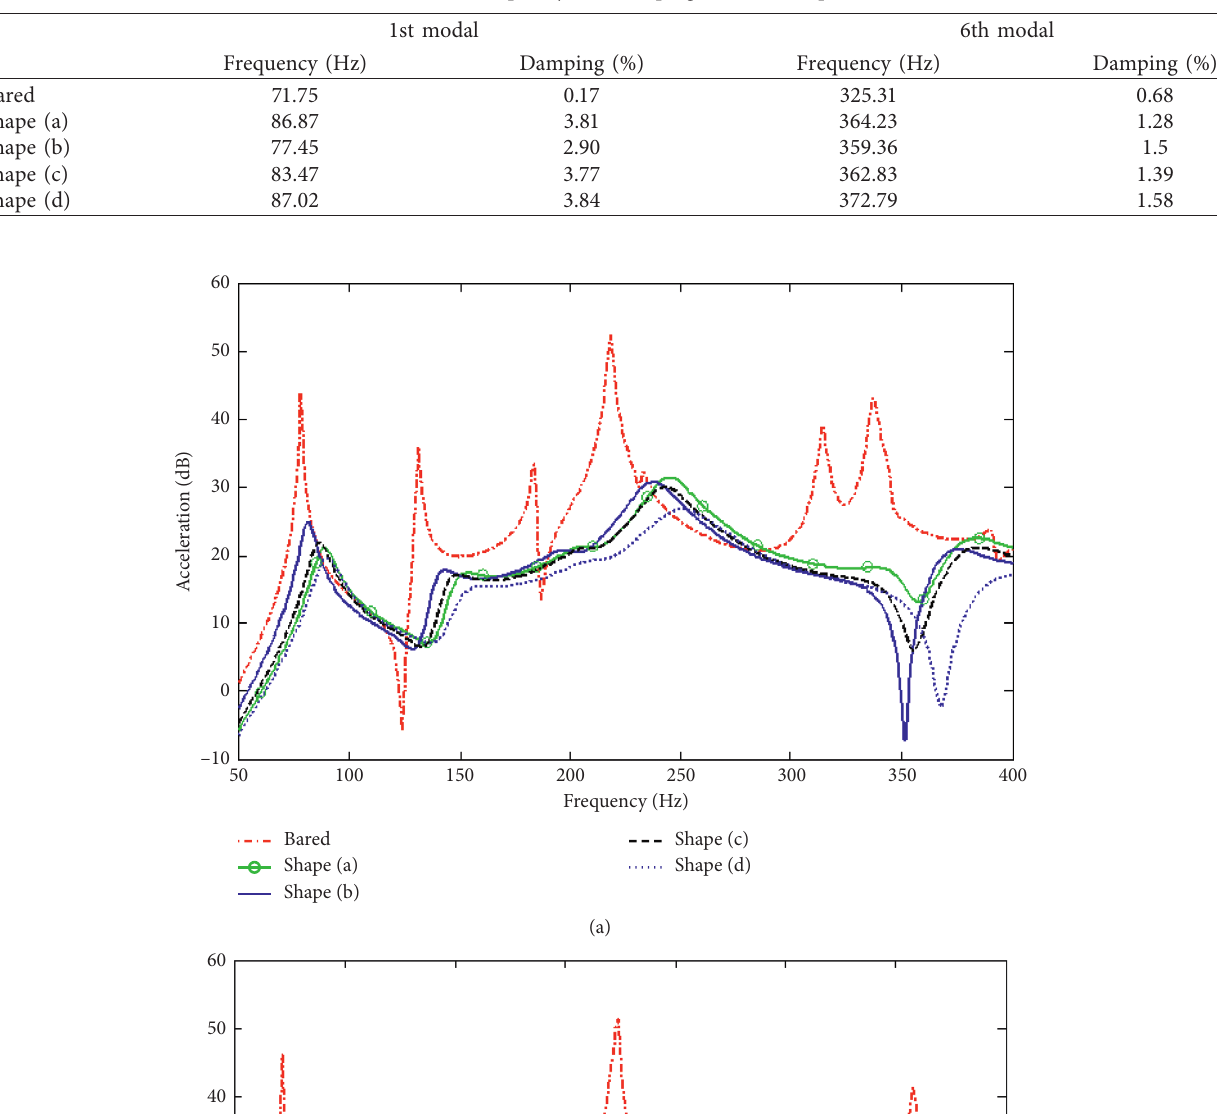
Table 1: Modal frequency and damping ratio of test plates.